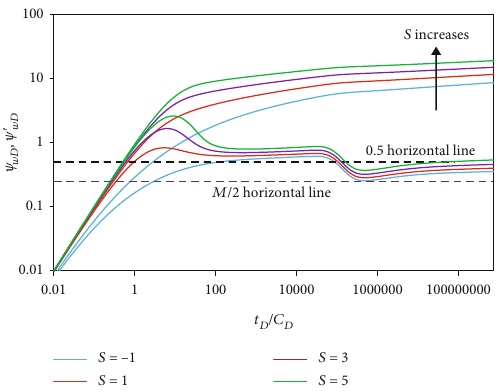
Figure 12: Well test curves of the pressure drawdown well test under di ff erent skin